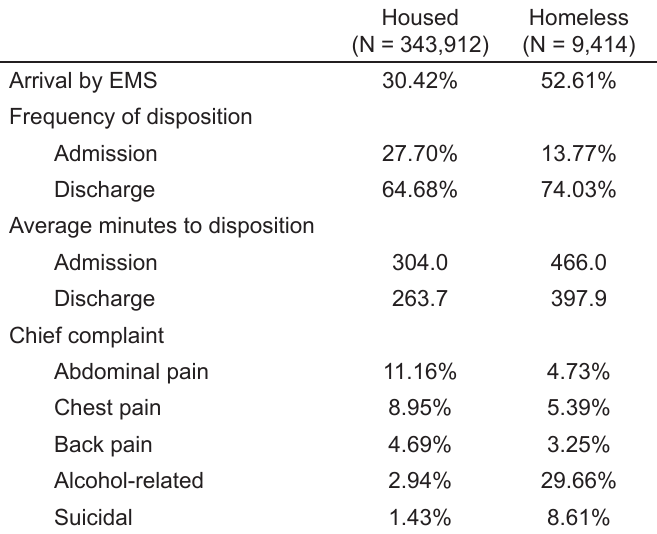
Table 2 . Emergency department visit characteristics for housed vs homeless patients at Rhode Island Hospital and The Miriam Hospital.